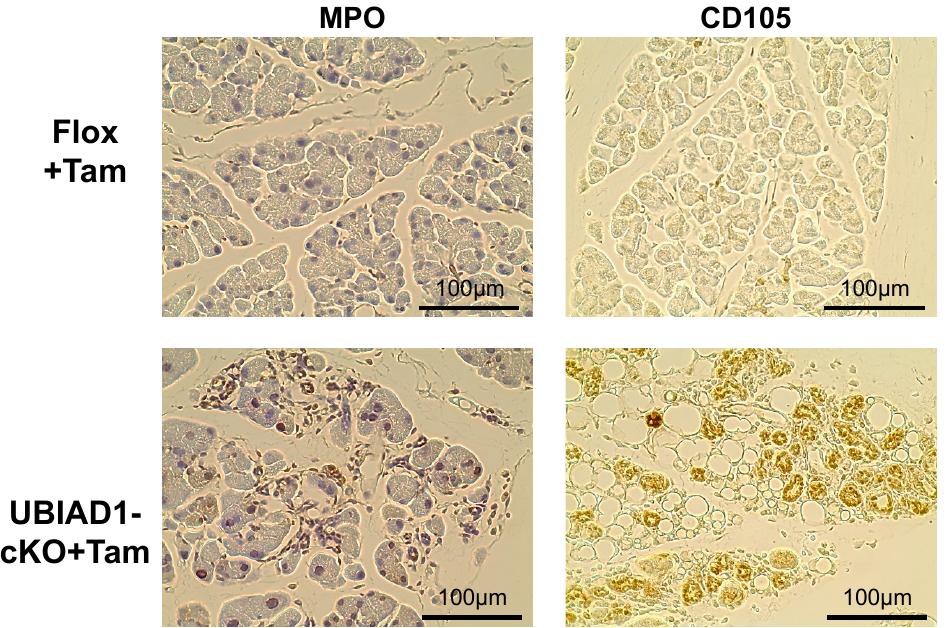
Figure 7. The pancreas of the tamoxifen-treated UBIAD1-cKO mice was positive for the inflammation (myeloperoxidase; MPO) and mesenchymal stromal cell (CD105) markers. Immunohistological staining of MPO and CD105 in the pancreas of tamoxifen-treated Flox and UBIAD1-cKO mice at 40 days after administration of tamoxifen. The tissues of immunohistological staining with MPO staining were counterstained with hematoxylin.